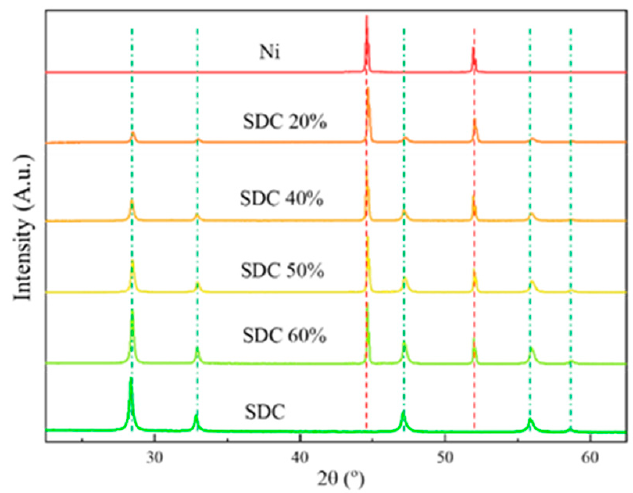
Figure 9. X-ray diffraction patterns of the obtained composite compared with pure Ni and SDC powders. SDC phase is marked with a green dash-and-dot line, Ni phase with a red dashed line.